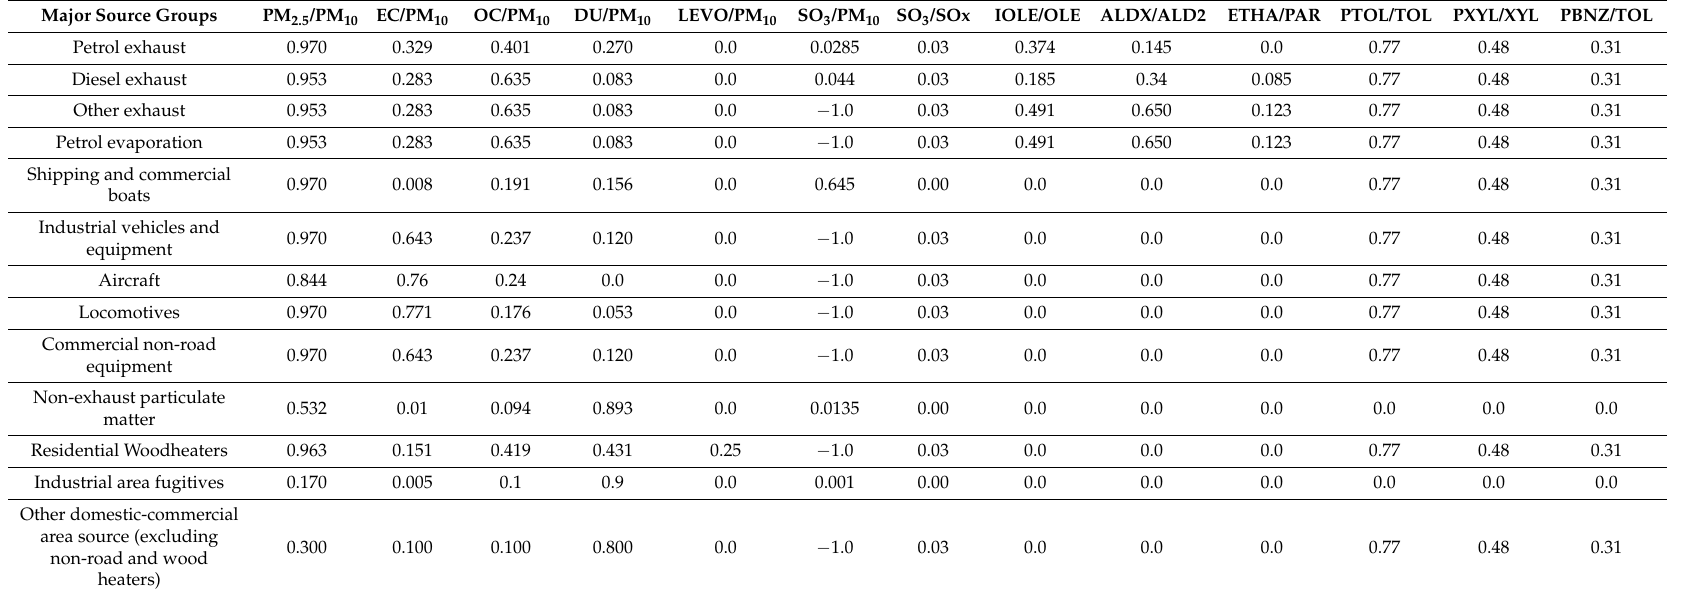
Table A1. The source-dependent fractions for major source groups used in emission